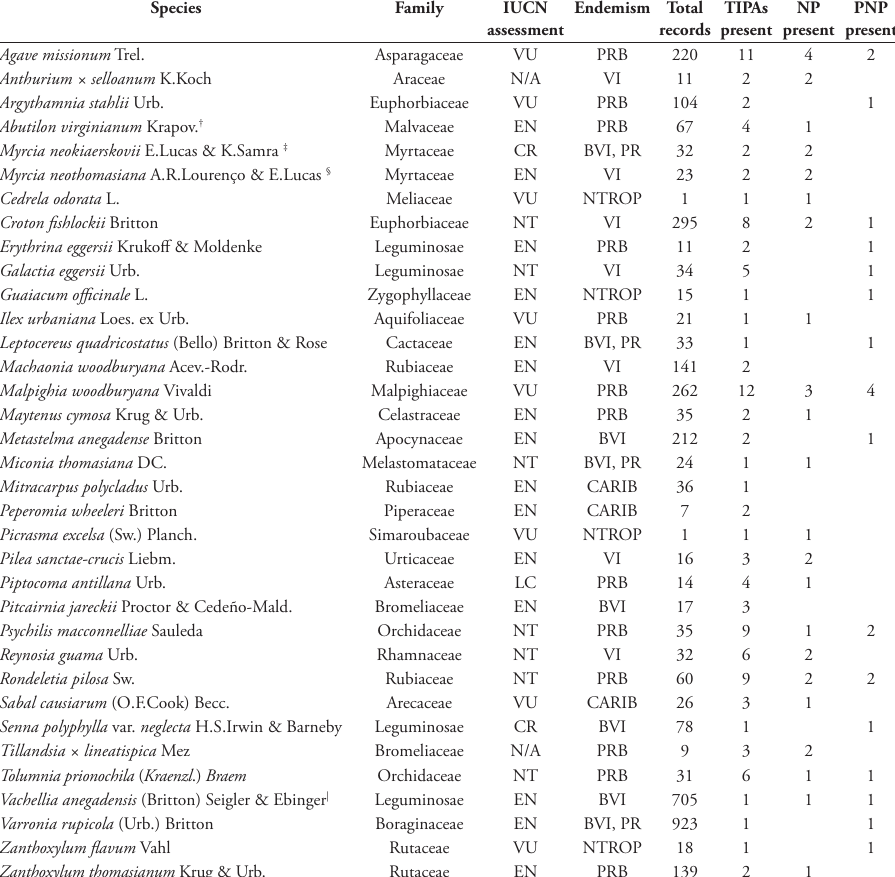
Table1. Species of Conservation Concern, their threat status, distribution and occurrence in TIPAs and National Parks. All species names according to Plants of the World Online Portal (POWO 2021). Glob- ally threatened status according to IUCN criteria v. 13. IUCN assessments under synonyms for four spe- cies † Bastardiopsis eggersii (Baker f.) Fuertes & Fryxell, ‡ Calyptranthes kiaerskovii Krug & Urb., § Calyptran- thes thomasiana O.Berg and | Acacia anegadensis Britton. Abbreviations: Neotropics (NTROP), Caribbean Region (CARIB), Puerto Rican Bank Floristic Region (PRB), US and British Virgin Islands (VI), British Virgin Islands (BVI) and Puerto Rico (PR), Tropical Important Plant Areas (TIPAs), National Park (NP), Proposed National Park (PNP).